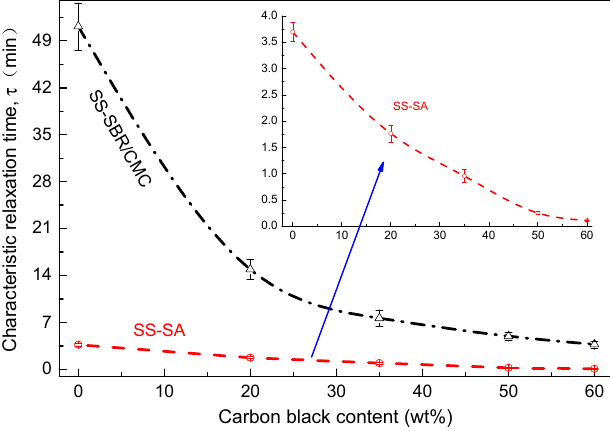
Figure 4. Evolution of the characteristic relaxation time of BCC films against carbon black content.